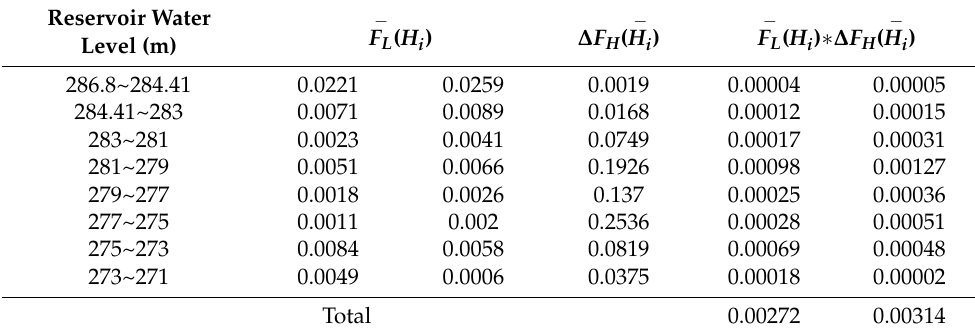
Table 6. Fuzzy risk probability value under all water levels of the reservoir ( α = 0.5).